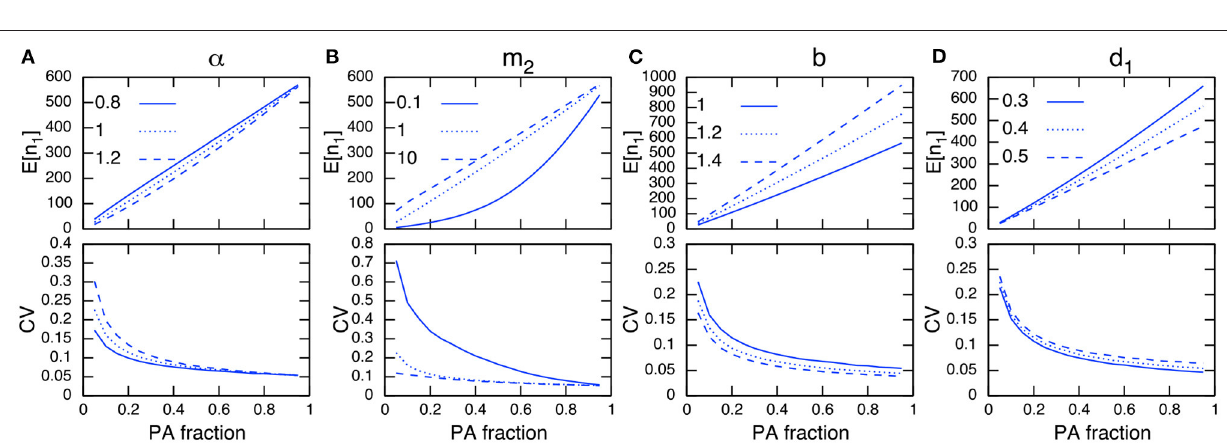
Frontiers in Ecology and Evolution |